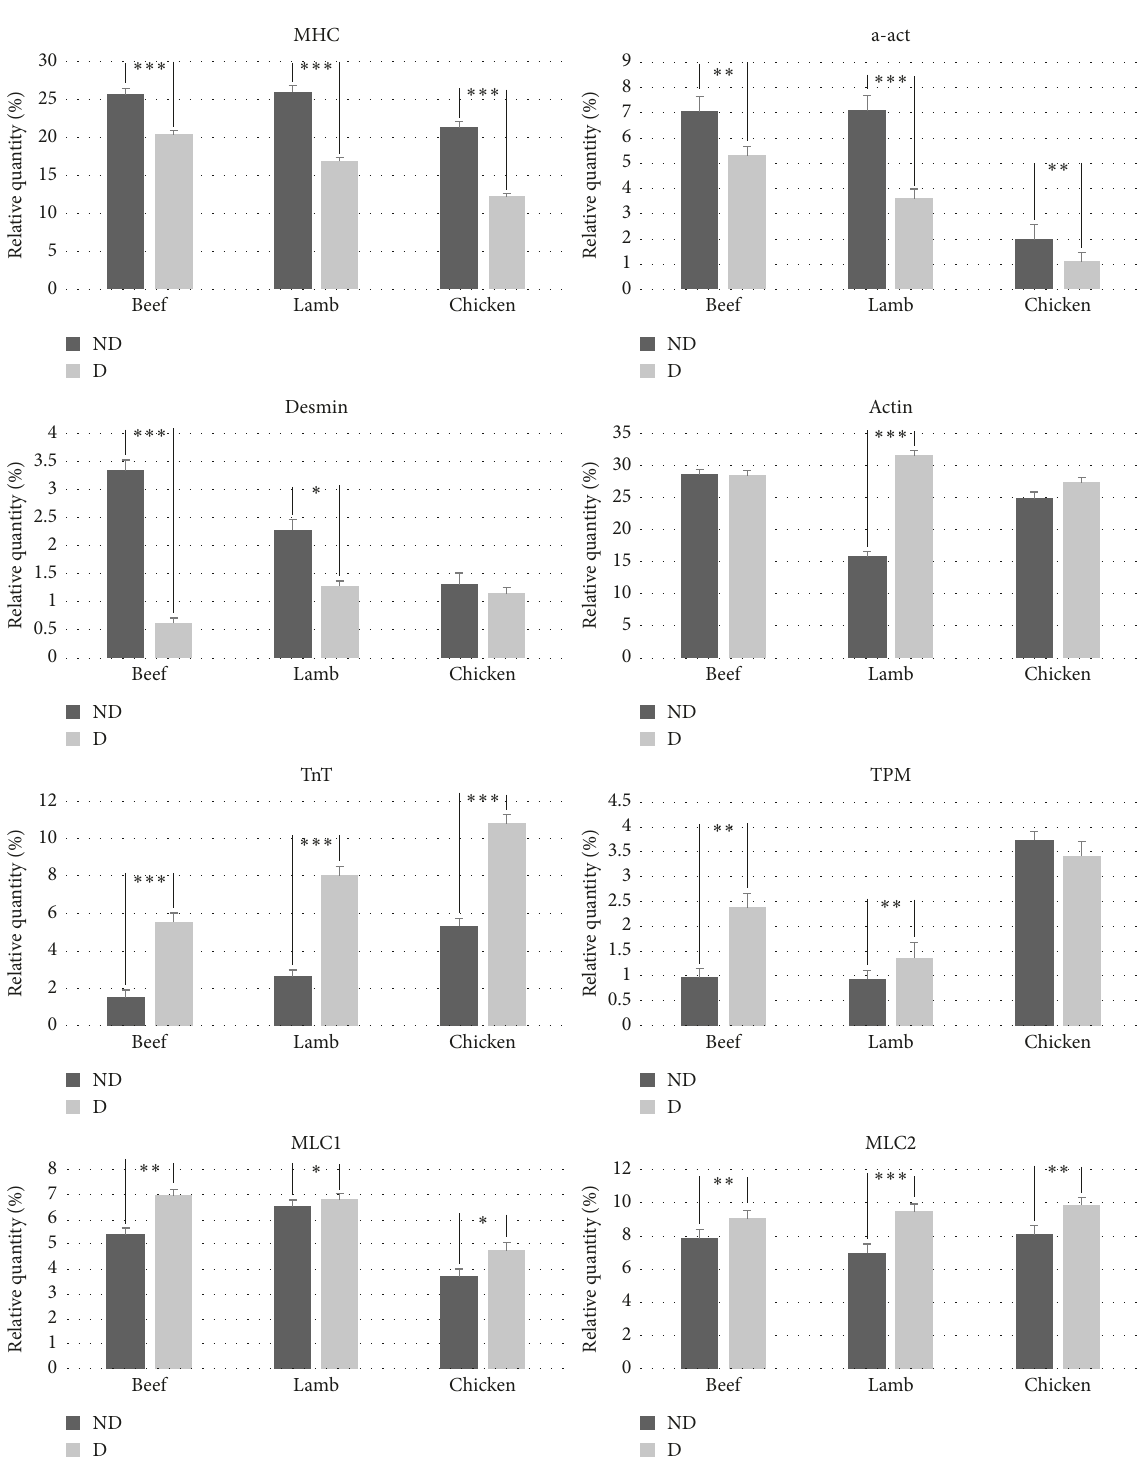
solution could have led to a modification of the physiological conditions of protein due to change of pH improving the